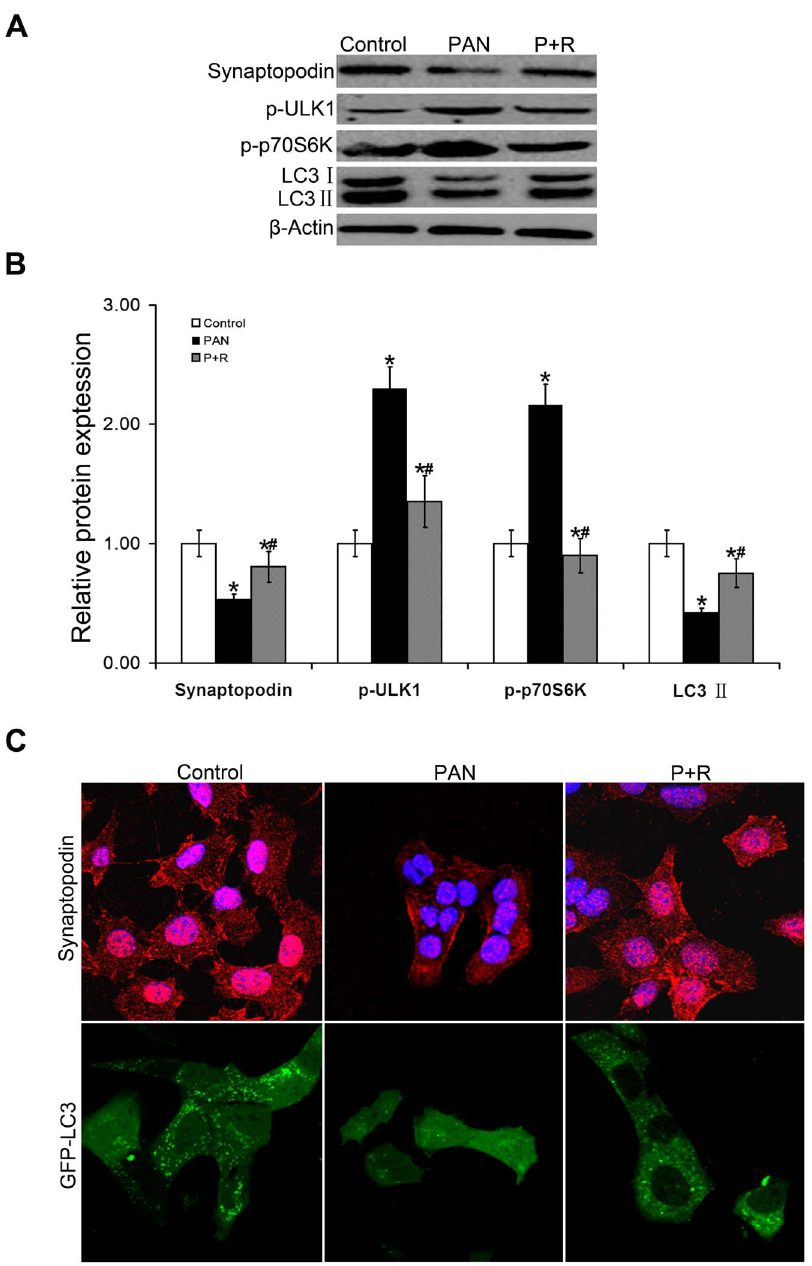
Figure 5. Rapamycin reduced podocyte injury by inhibiting the mTOR-ULK1 signaling pathway. (A–B).Western blot analysis of cellular proteins showed recovery of synaptopodin and LC3 II expression, a decrease in mTOR activity, and a decrease in ULK1 phosphorylation in rapamycin- pretreated cells (P + R) compared to PAN-treated cells in the absence of rapamycin (PAN), * P , 0.05 vs Control, # P , 0.05 vs PAN. (C).P + R podocytes appeared healthy with relatively round nuclei, enhanced synaptopodin expression (red fluorescence), and increased cellular GFP-LC3 granular expression (green fluorescence) compared to PAN cells. Magnification = 6 1200.